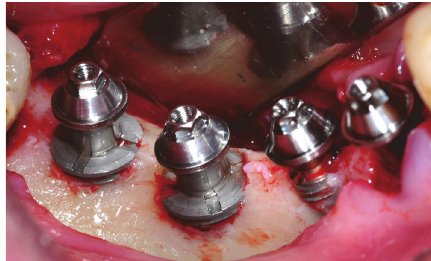
Figure 6: Abutments for multiple prosthesis installed during the surgery.